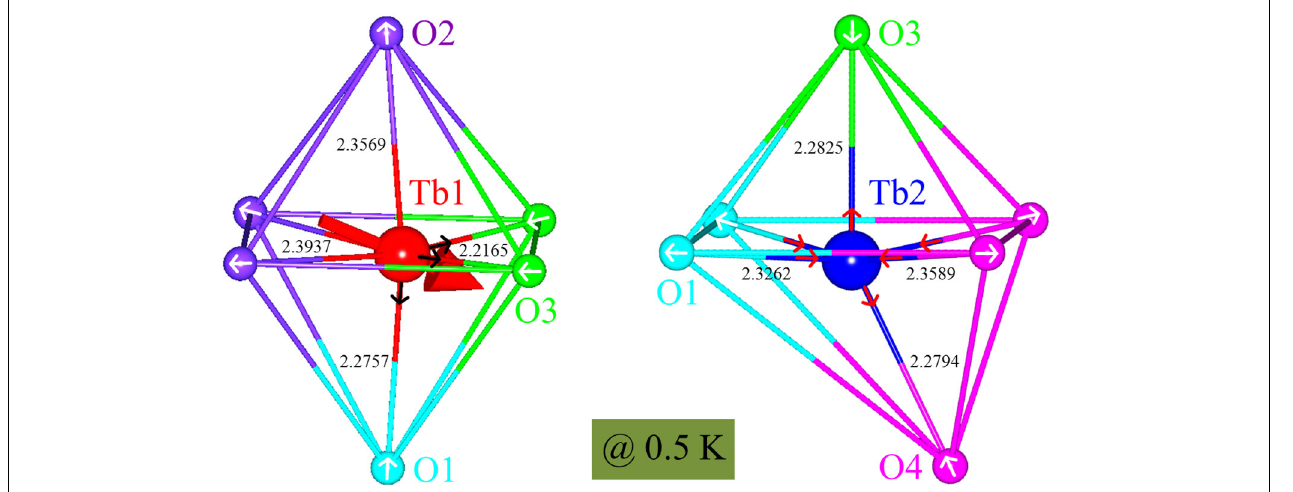
Tb1 ion represents the Tb1 moment. The small arrows sitting on the O ions or the Tb-O bonds schematically show the deduced octahedral distortion modes as displayed.